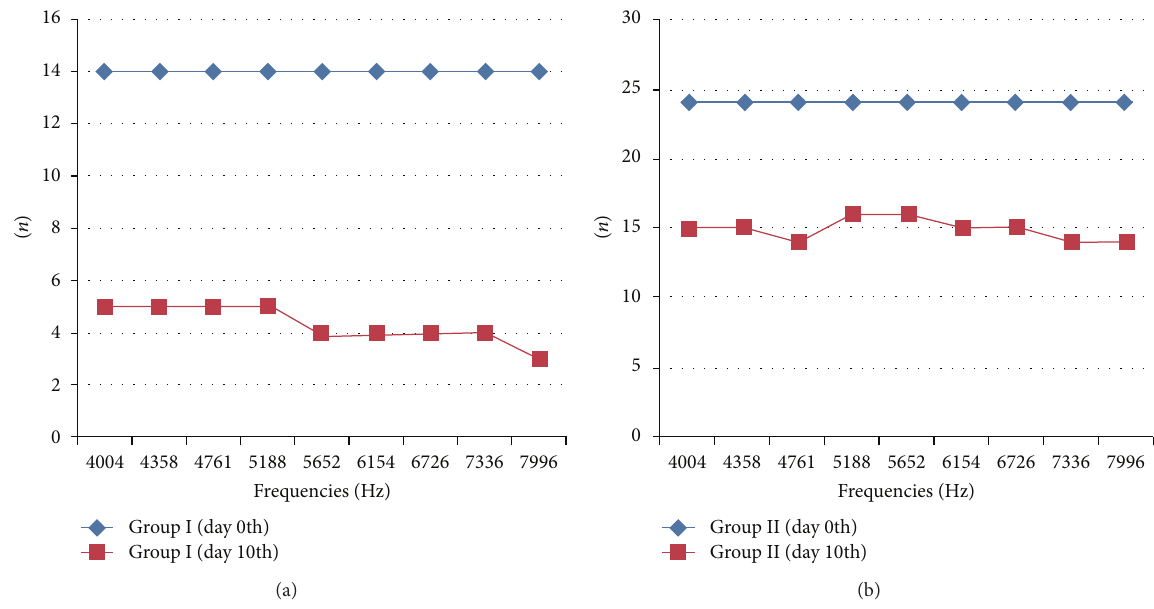
Figure 2: The number of the rats that have hearing before and after cisplatin administration in group I (a) and in group II (b).